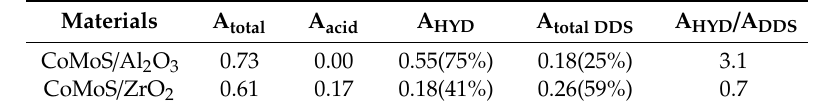
Figure 4. Transformation ways of 46DMDBT (HYD: hydrogenation route, DDS: direct desulfurization route, sulf: sulfide phase, acid: acid properties, dism: dismutation, isom: isomerization. 4,6-DMDBT: 4,6-dimethyldibenzothiophene, MCHMB: methylcyclohexylmethylbenzene, MBPh: methylbiphenyl, DMDBT: dimethyldibenzothiophene, DMBPh: dimethylbiphenyl, TMDBT: trimethylbiphenyl, MBPh: methylbiphenyl). Table 3. The 46DMDBT HDS activities (A mmol.h − 1 .g − 1 ) and selectivity (%) obtained for CoMoS / Al 2 O